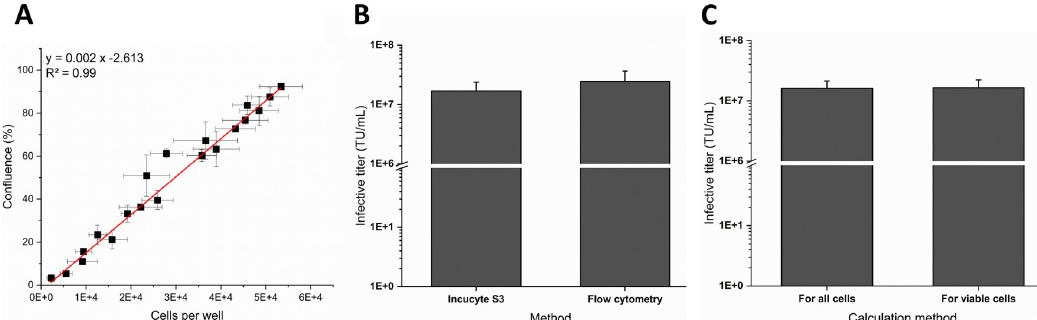
Fig 6. Infectious titer calculation. (A) Correlation of cell count and cell confluence. The cell confluence measured 7 h after cell seeding with the Incucyte 1 was plotted against the cell count seeded per well as determined by the Cedex HiRes 1 Analyzer. Mean ± standard deviation, linear regression fit applied (red line) with R 2 = 0.99. (B) Infective titer for viable cells determined by the Incucyte 1 S3 and by flow cytometry. (C) Infective titer for three samples of different virus dilutions within the linear range of the Incucyte 1 -based assay calculated either for all cells or for viable cells. Data represent the mean ± standard deviation of three biological